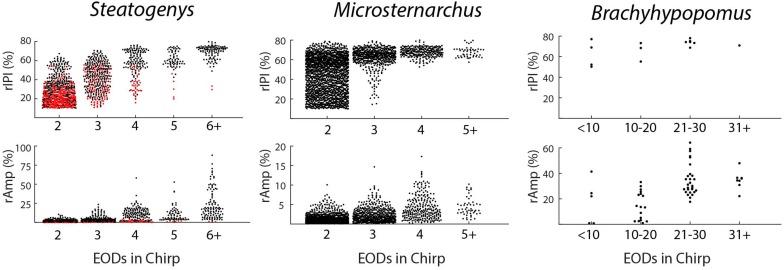
Beeswarm plots of chirp parameters for all three species. The upper and lower panels depict the distributions of maximum IPI reduction and EOD amplitude reduction, respectively, each plotted as separate distributions according to the number of EODs comprising the chirp. In the Steatogenys panels, red circles indicate chirps recorded from the dF experiment group and black circles indicate chirps recorded from the EOD duration experiment group.